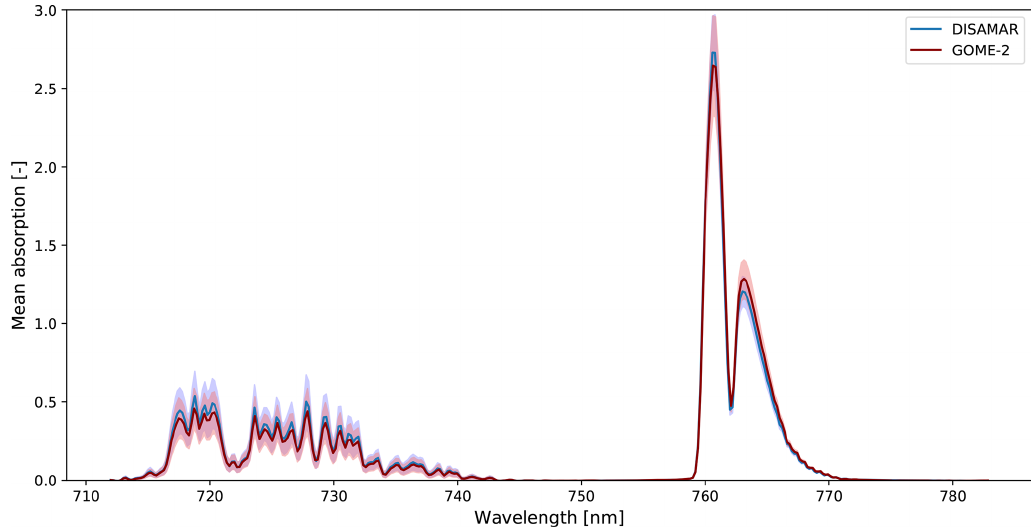
Figure 2. Mean wavelength-dependent absorption spectra for GOME-2A (red, n ≈ 30000) and DISAMAR-generated (blue, n = 2000) top- of-atmosphere spectra, with n the number of spectra. The mean absorption corresponds to the two-way-slant optical thickness resulting from water vapour and oxygen absorption. The shading shows